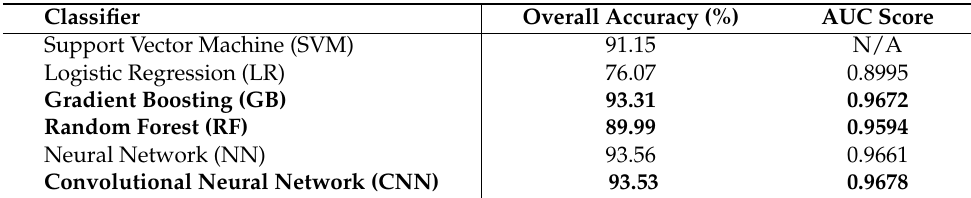
Table 2. Comparison of prediction accuracy (%) and area under ROC curve (AUC ROC) from different ML/AI models tested. Three models that achieved the highest accuracies are highlighted in bold, and all results shown below are from these three